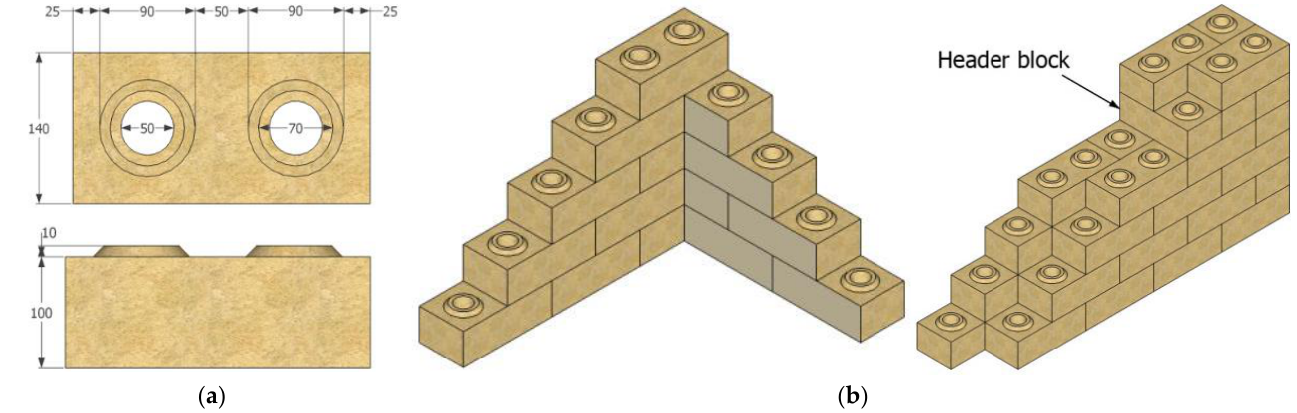
Figure 4. Building system adopted for the experimental program [45]: ( a ) geometry of the iCEBs and ( b ) running bond pattern for single-leaf and double-leaf walls.